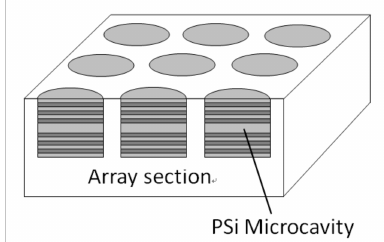
Figure 16. The structure of the PSi microcavity